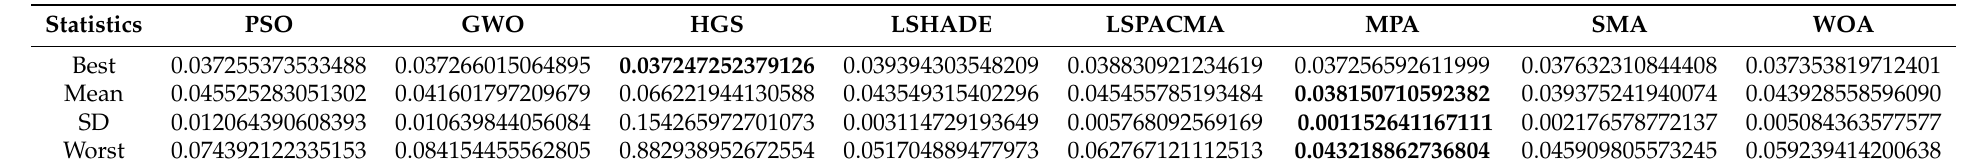
Table 5. Experimental result of RMSE with 40 individuals, 20 evolutions and 30